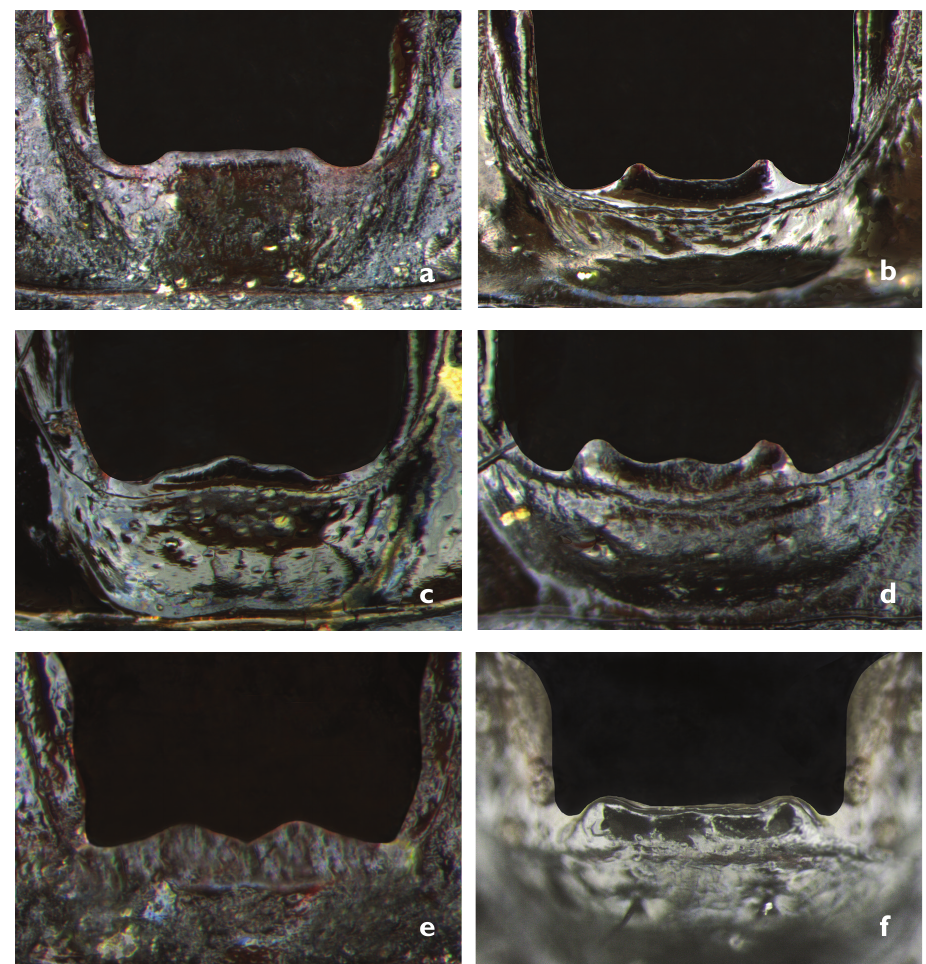
Figure 3. Mentum morphs of the Graphipterus serrator group: a No teeth ( G. barthelemyi ) b Two teeth with concavity between them ( G. heydeni ) c Two teeth as margin between them slightly convex in middle. ( G. valdanii ) d Three teeth ( G. peletieri ) e Two pronounced teeth ( G. minutus minutus ) f Three teeth, mid tooth very shallow ( G. serrator